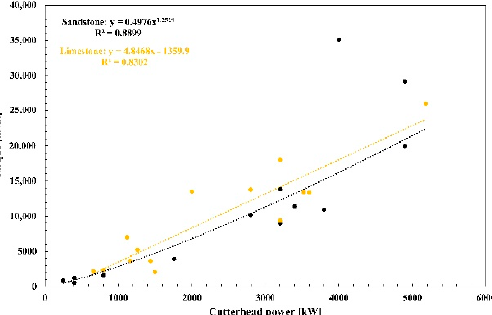
Figure 16. Correlation between the power and the torque due to the excavation in sandstone and limestone by single shield TBMs.